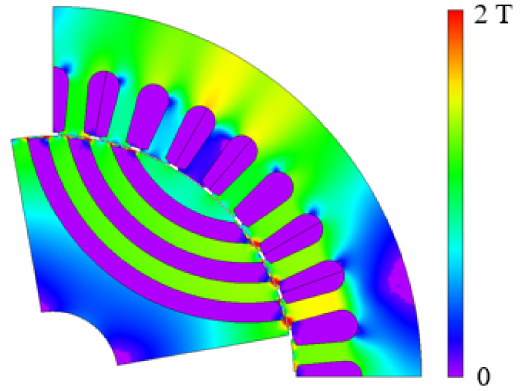
Figure 6. Shape and magnetic flux density of sample